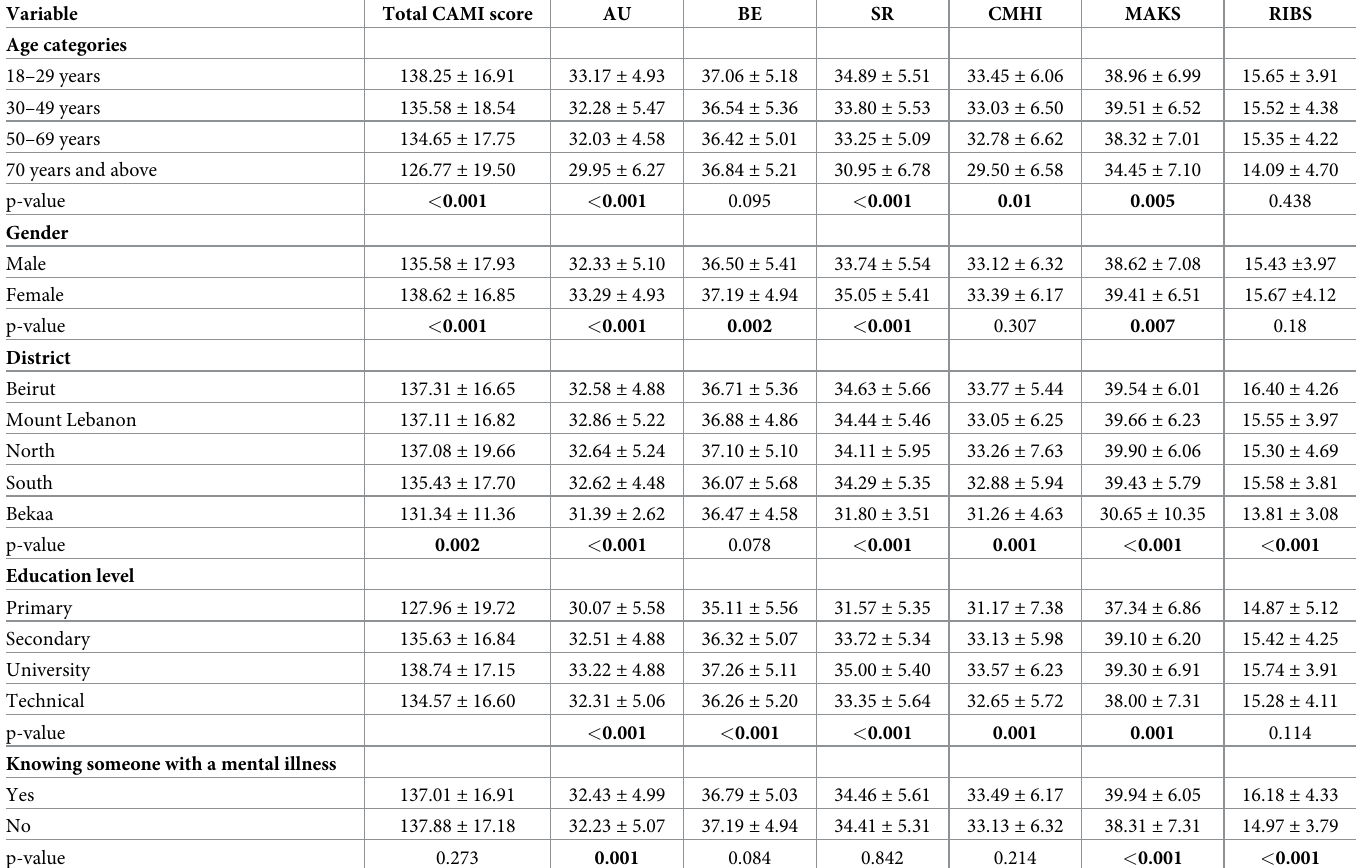
Table 2. Bivariate analysis of sociodemographic factors associated with each subscale of the CAMI